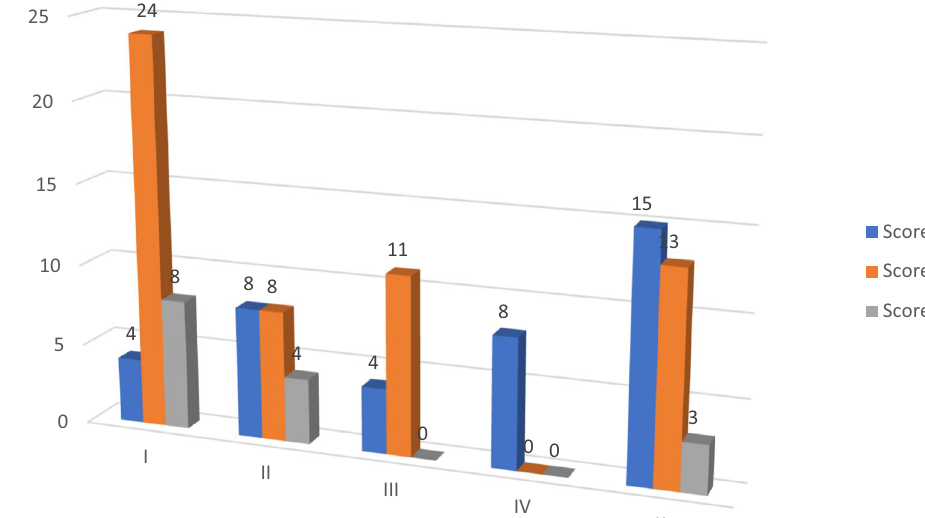
Figure 2. Distribution of the severity and number of WSLs in the study and control groups at the final examination (T4).